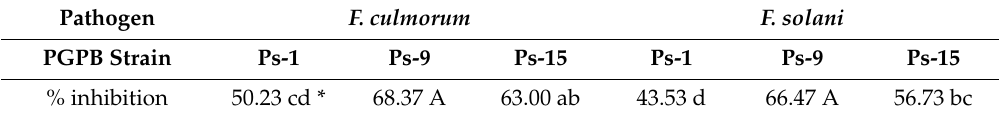
Table 1. Antagonistic properties of isolated bacteria strains tested against Fusarium spp. cultures.